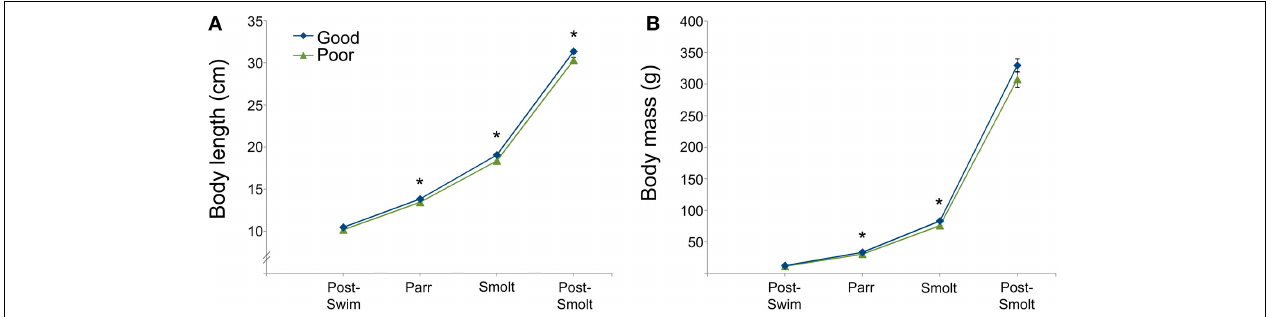
FIGURE 3 | The average (A) body length ± SE and (B) body mass ± SE of poor and good swimmers when tested at different time points after the swimming endurance experiment; directly after swimming (Post-Swim, N = 960 per group), at parr